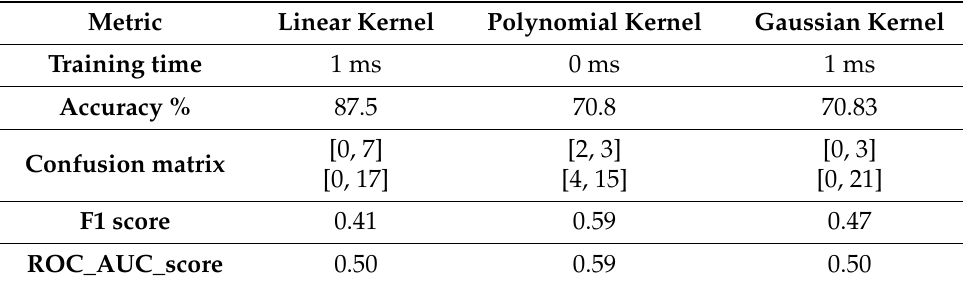
Table 2. Offline Dataset SVM.